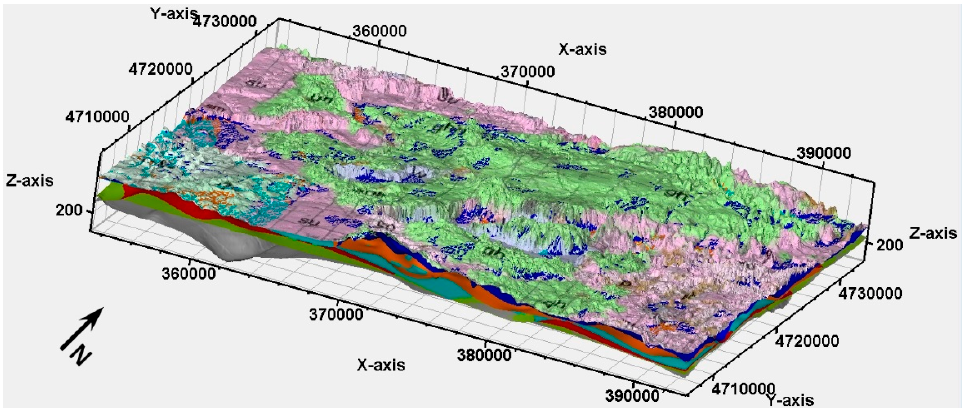
Figure 6. 3D Petrel geologic model of Quaternary sediments in Walworth County, WI. The top most surface is the Haeger Member with the geologic map of Walworth County prepared by Ham and Attig, 2004 draped over top. Coordinates are UTM.